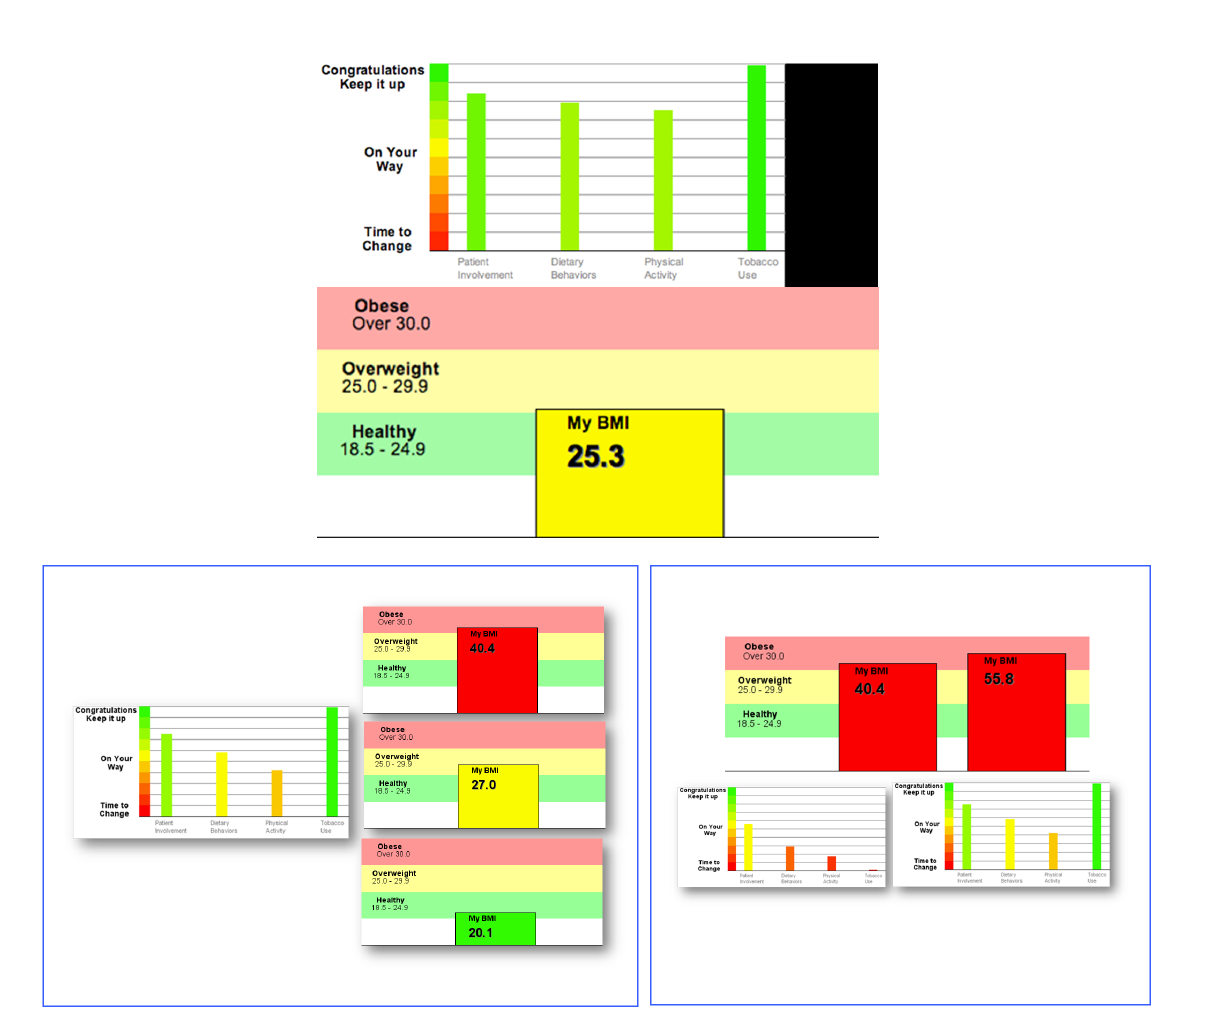
Figure 1. Sample screen shots of iPod Touch